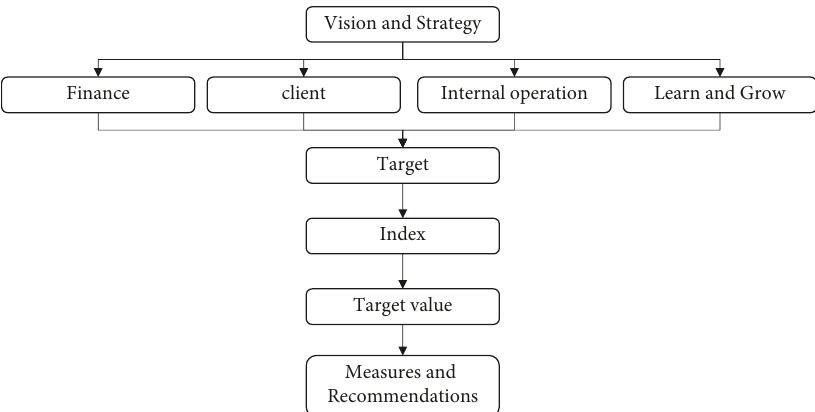
Figure 2: The strategy elaboration